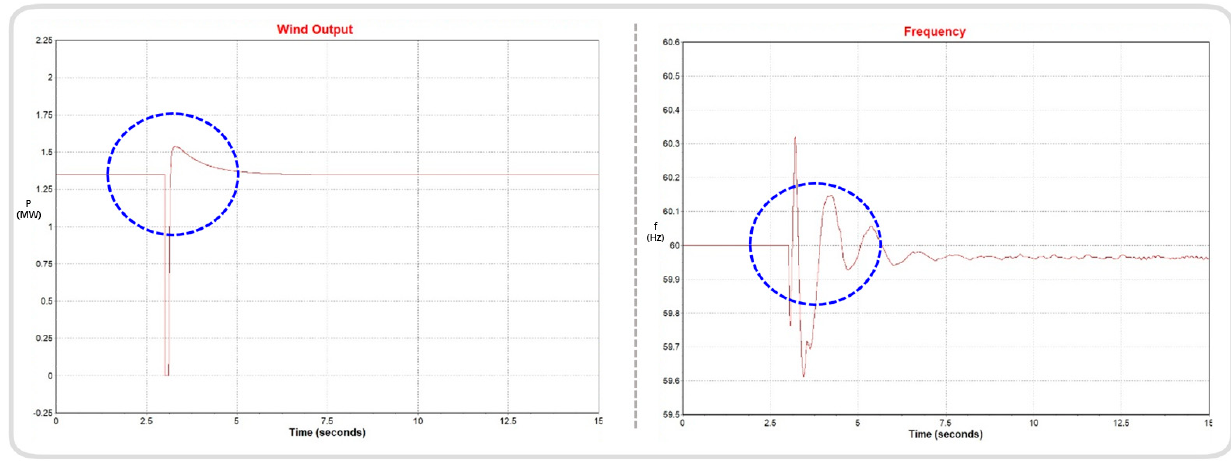
Figure 19. Comparison of wind power generator output characteristics according to frequency re- sponse characteristics.